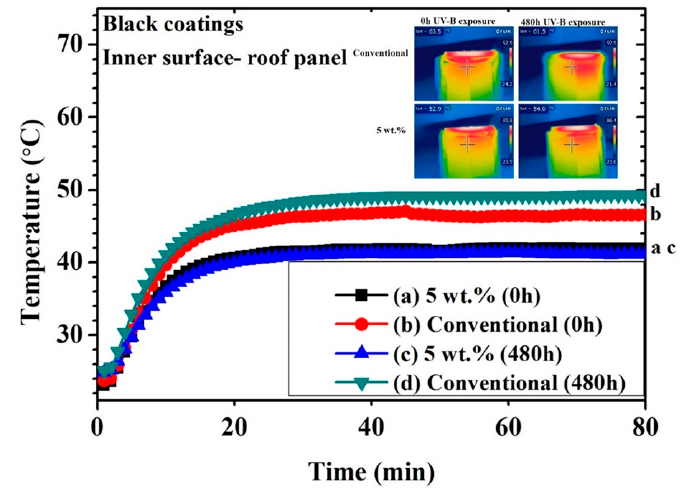
Figure 6. Thermal measuring points for black coatings (inner surface of roof panel) obtained with a thermocouple and an IR camera.